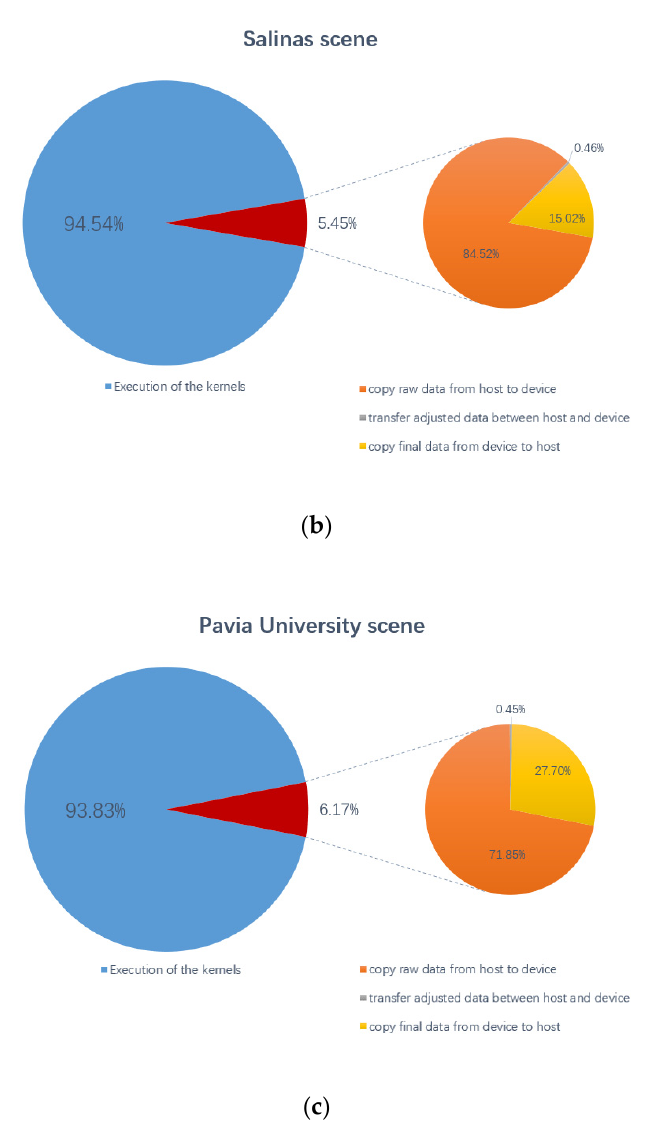
Figure 8. Percentages of the total GPU time for kernel execution and data transfers. ( a ) Indian Pines; ( b ) Salinas scene; ( c ) Pavia University scene.